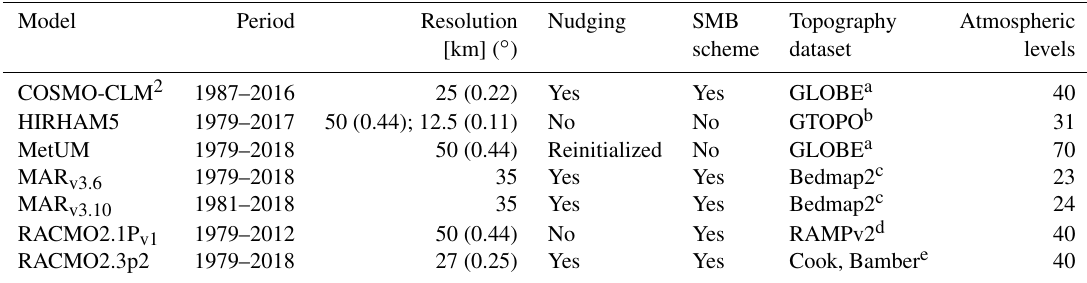
Table 1. Summary of differences and similarities between the RCMs. Horizontal resolution is given in degrees and (kilometres), while the number of atmospheric levels refers to the vertical resolution. Nudging refers to the level of forcing within the domain; refer to the individual model descriptions for more